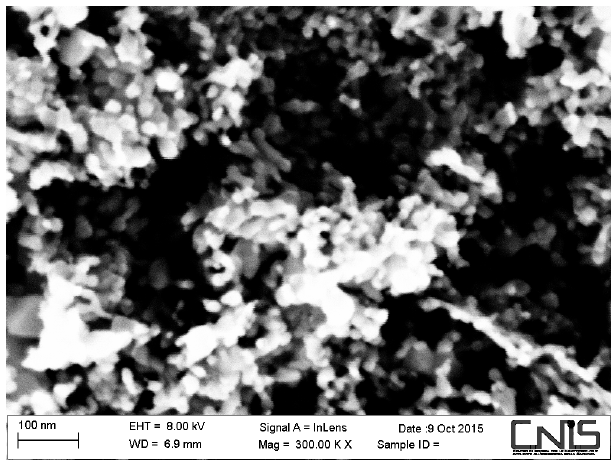
Figure 1. SEM picture of the mesoporous NiO film (thickness, l = 2 μ m) here employed as the working electrode and dye-sensitized solar cells of p -type ( p -DSC) photocathode.